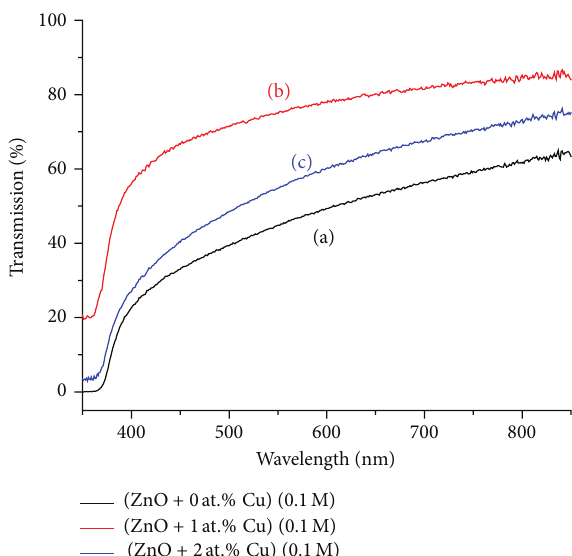
Figure 3: Transmission spectra of undoped and Cu doped ZnO thin films sample. Here (a), (b), and (c) correspond to samples Z1, Z1C1, and Z1C2, respectively, prepared using precursor solution of molarity of 0.1M.